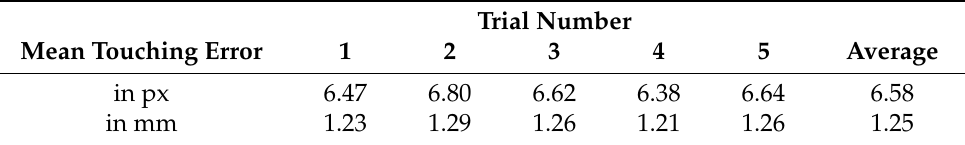
Table 9. Demonstration result after first-stage optimization.